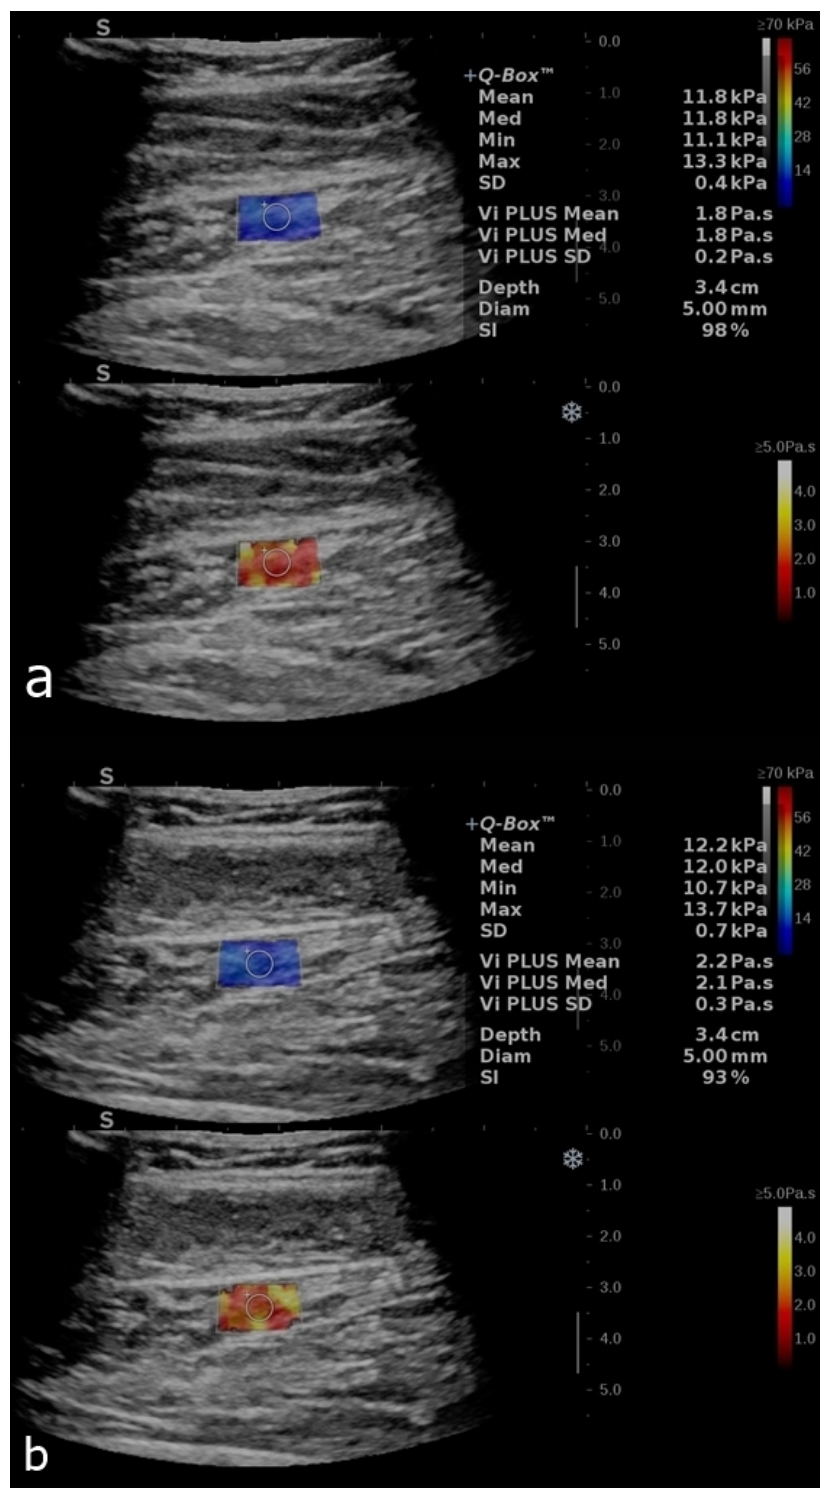
Figure 4. B-mode image with an elastogram of the calf muscle in a healthy volunteer. Longitudinal plans of the calf muscles as follows: relaxed ( a ) and after contraction ( b ). The regions of interest (ROIs) were placed in the box when the homogenous coloring of the box was obtained with a stability index of over 90%. The top image reflects the SWE mode, and the bottom image reflects the ViPLUS application. ROI values are expressed in kPa for SWE and Pa.s for ViPLUS.